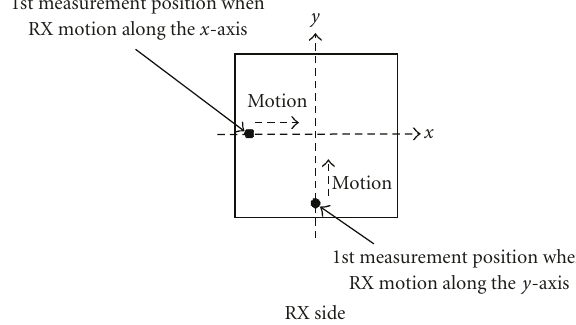
Figure 8: The first spatial measurement position.